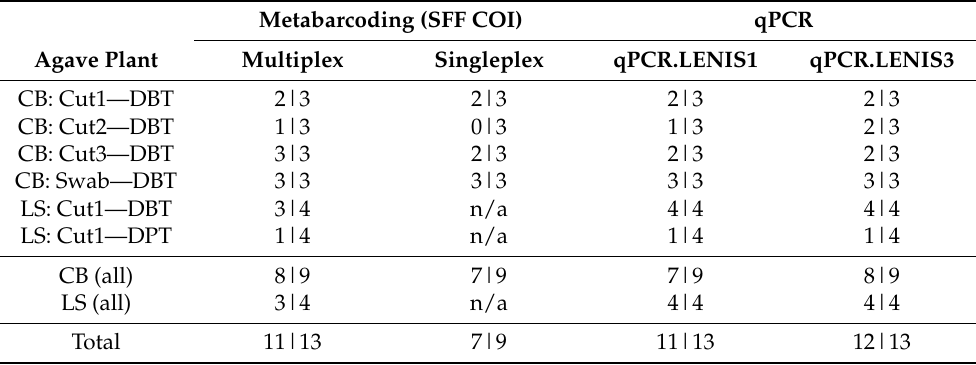
Table 3. L. nivalis detections from flower samples ( n = 13) of two agave plants, with various sampling, stabilization, extraction methods (number detected|number tested), substrates, or DNA extraction kits. Cut1 consists of stigma, style, and ovary, shipped un-stabilized. Cut2 consists of stigma, style, and ovary, shipped in RNAlater. Cut3 consists of half of a pistil and remaining RNAlater. DBT = Dneasy Blood and Tissue Kit. DPT = Dneasy Plant Tissue kit. Samples marked as “n/a” were untested for a detection method. LS = Sierra Madre Oriental in Laguna de Sanchez, Nuevo Le ó n, Mexico; CB = Chisos Mountains in Big Bend National Park, Texas,